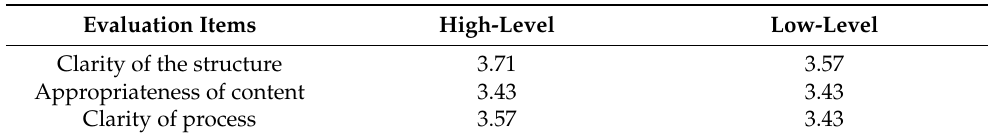
Table 5. Mean value of the conceptual high-level and low-level BC-PSSs framework (responses of industry experts and